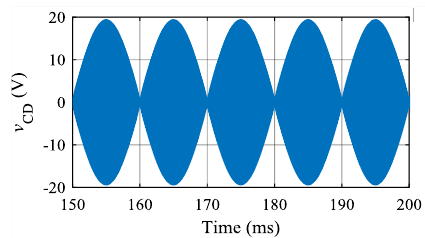
Figure 16. The envelope of the transformer secondary voltage v CD ( φ 1 = π /2, θ = π /2).